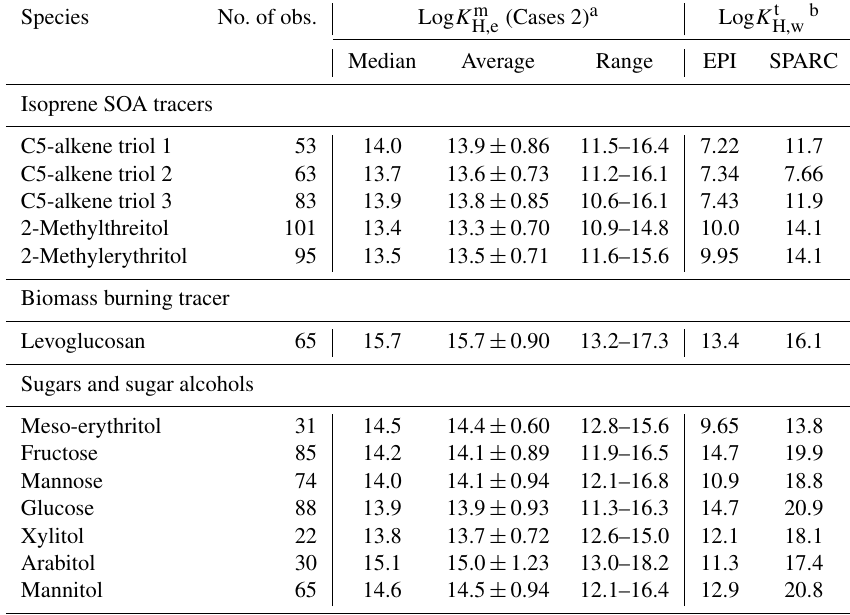
a Logarithms with base 10 ( log K m H,e values of Case 3 had ignorable difference and were not exhibited separately). b Temperature range: − 4 ∼ 36 ◦ C